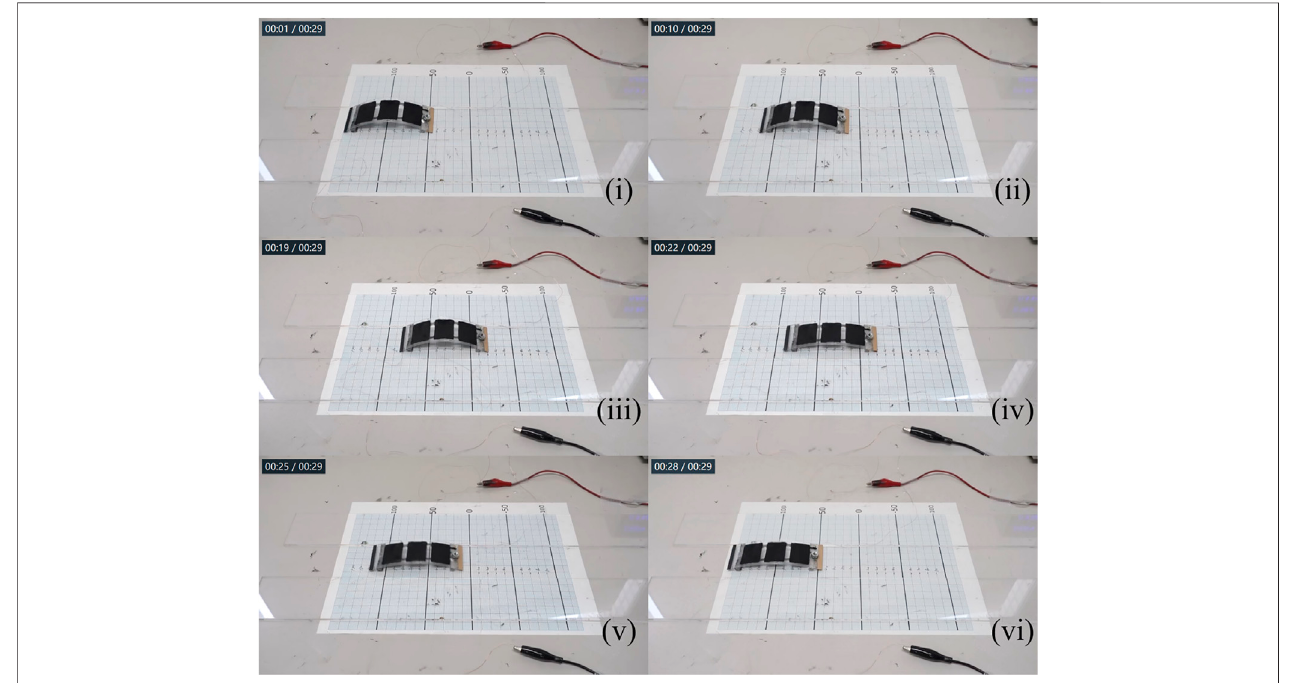
Frontiers in Robotics and AI |